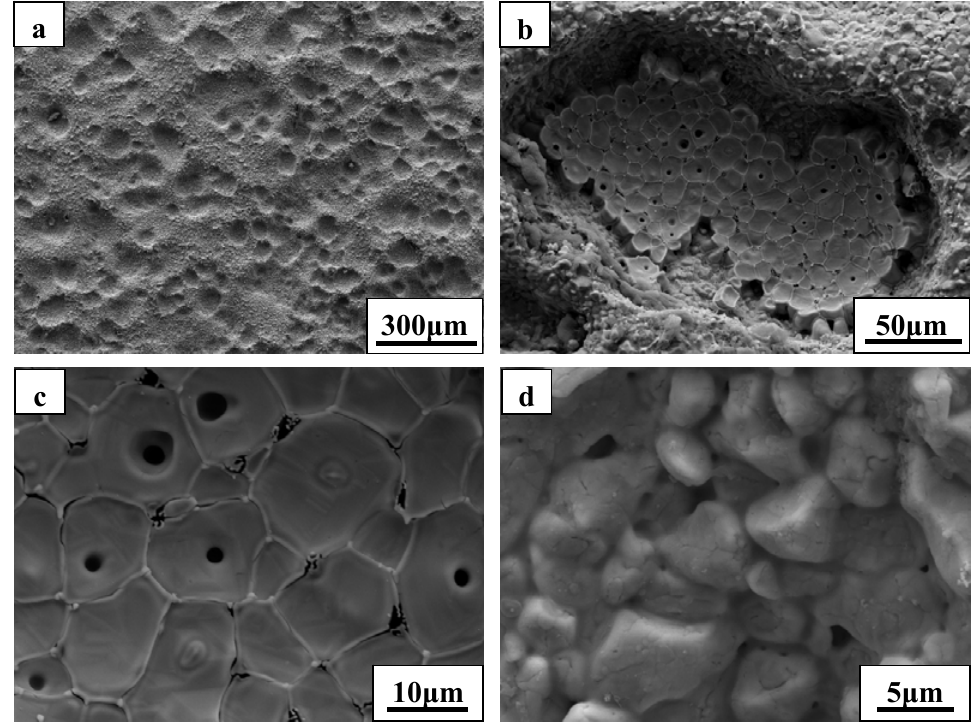
Figure 6. SEM micrographs of the substrate for ZS10 after ablation under condition